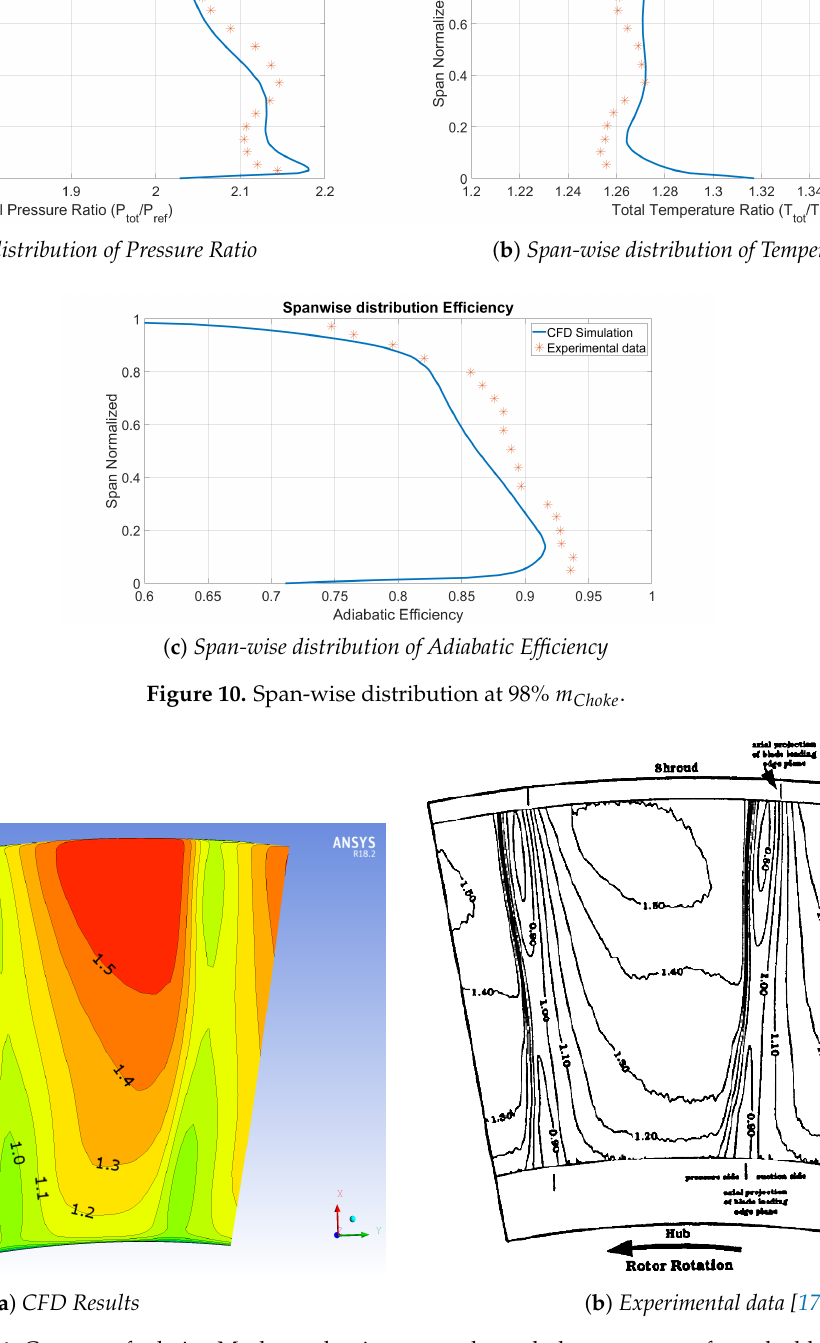
Figure 11. Contour of relative Mach number in a cross-channel plane upstream from the